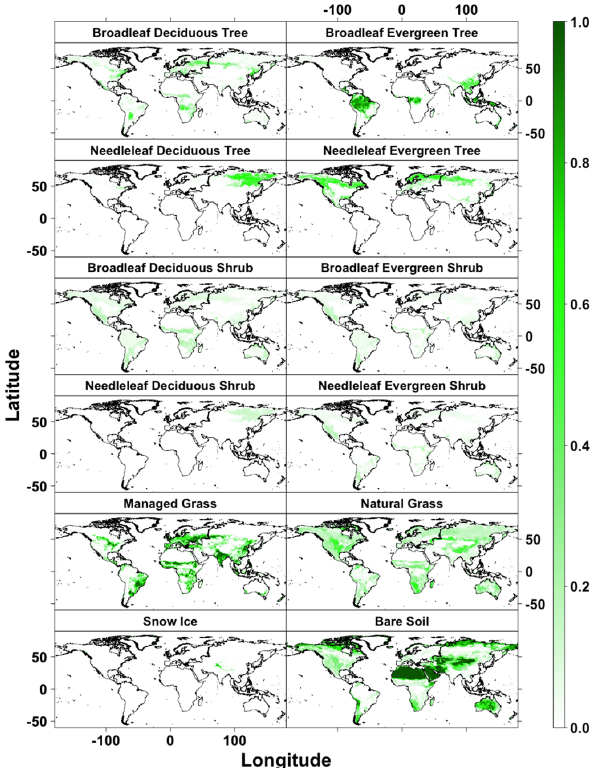
Figure 3. Fractional coverage of plant functional types, at 0.5 ◦ spa- tial resolution, calculated from original 300m LC_CCI data set, epoch 2008–2012, using the LC_CCI conversion